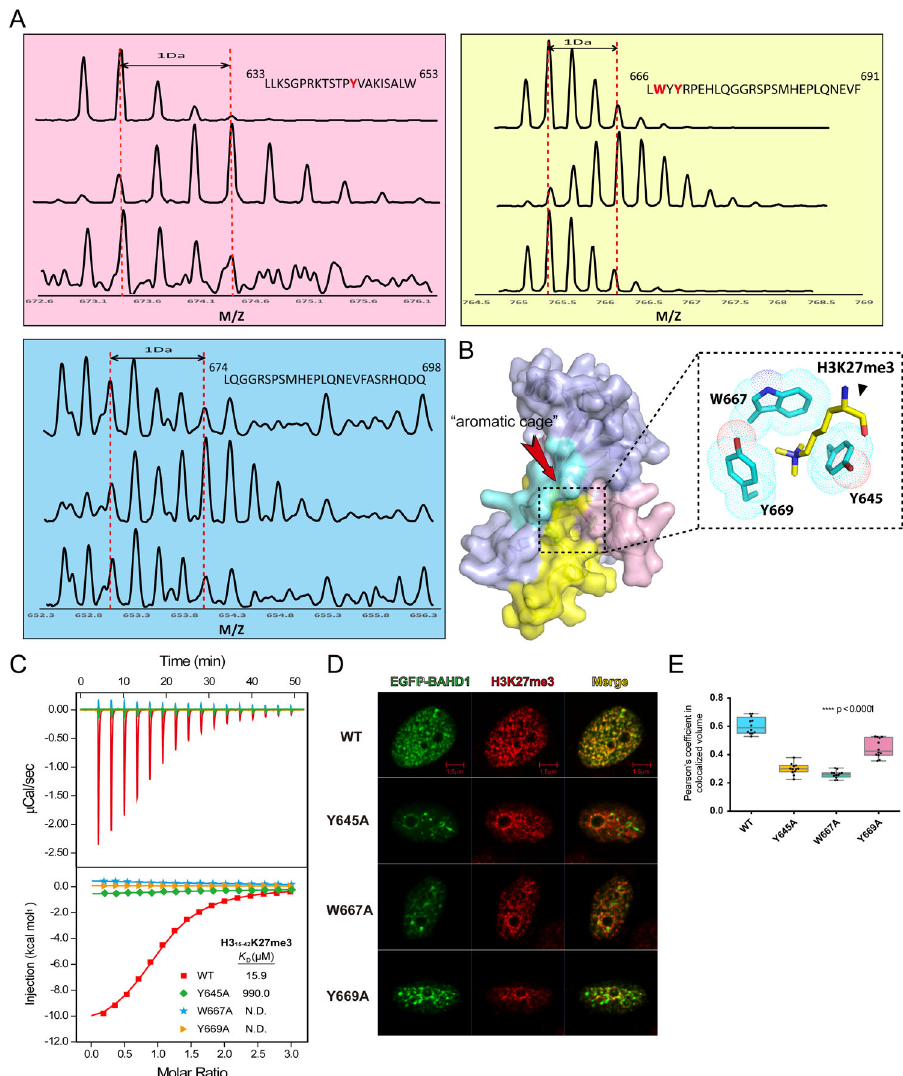
Figure 2. An aromatic cage is required for H3K27me3 recognition by BAH BAHD1 domain . (A) Hydrogen exchange MS (HXMS) analysis of BAH BAHD1 -H3K27me3 complexion. Representative deuterium exchange mass spectra of BAH BAHD1 peptide fragments. Sections of BAH BAHD1 peptides from 633 – 653 are shown in pink; 666 – 691 in yellow and 674 – 698 in blue (In each section, top: undeuterated sample; middle: BAH BAHD1 only peptides after 10 min in deuterated buffer; down: BAH BAHD1 with H3K27me3 after 10 min in deuterated buffer). (B) H3K27me3 binding region mapping of BAH BAHD1 based on the HX MS data. The structure model of BAH BAHD1 was obtained by homologous modelling. BAH BAHD1 structure is shown in surface view with the corresponding H3K27me3 binding region color coded pink, yellow, and cyan corresponding to panel (A). Arrow highlights the aromatic cage formed at the center of BAH BAHD1 . A close-up view of the aromatic cage with a modelled H3K27me3 ligand is shown top-right. (C) ITC fi tting curves of histone H3 15-42 K27me3 peptide with wild type (WT) and mutant BAH BAHD1 (Y645A, W667A, and Y669A). (D) Immuno fl uorescence of EGFP-BAHD1 and mutants transfected HeLa cells labeled with H3K27me3 antibody. Scale bar represents 5 μ m. (E) Quanti fi cation of EGFP-BAHD1 and mutants signals co-localized with H3K27me3. Counts are based on 12 interphase cells in individual clones and the Pearson ’ s coef fi cient of each cell was listed in Table